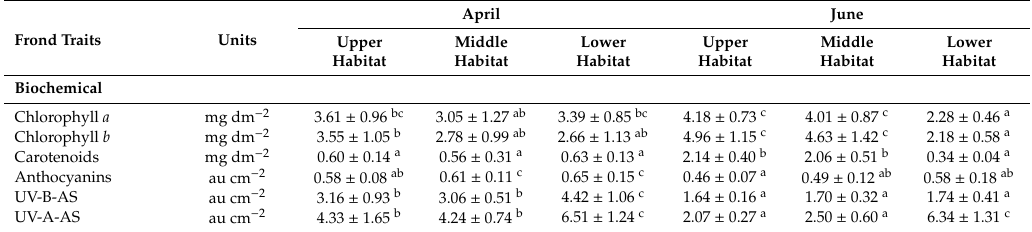
Table 1. Biochemical, morphological, and physiological traits of the Phyllitis scolopendrium fronds from the three habitats with di ff erent light conditions, sampled in April and